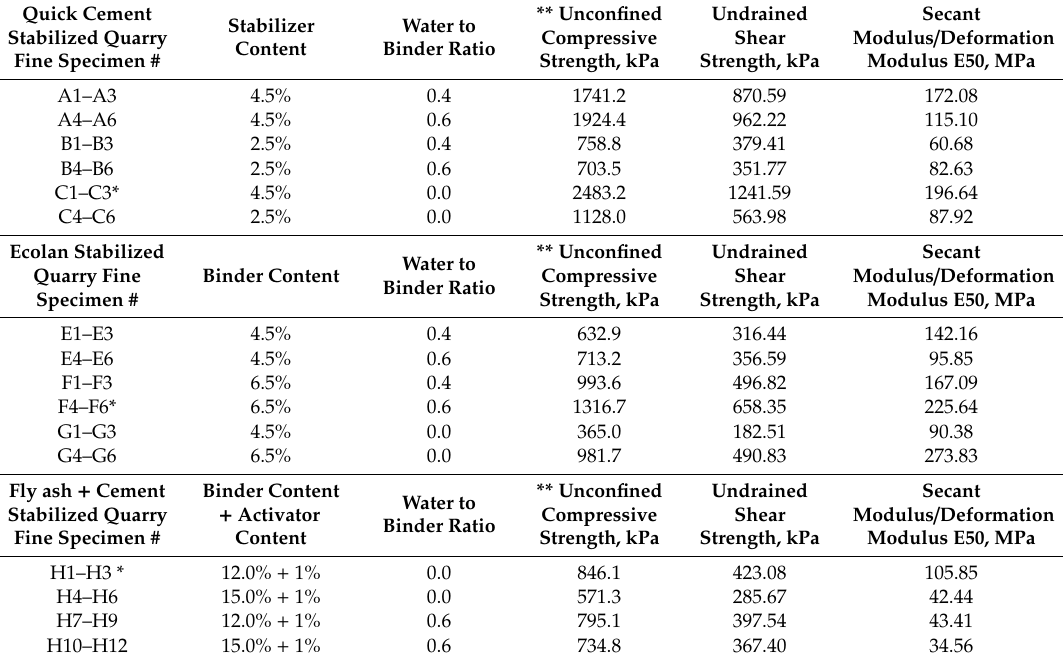
Table 2. Types of stabilized quarry fine specimens and their